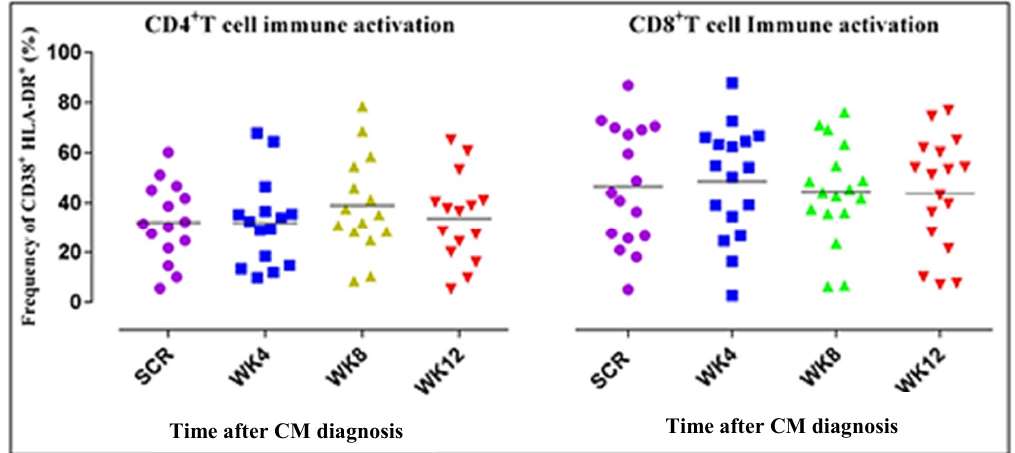
Figure 5. Immune activation levels remained elevated with of the T cell subsets.